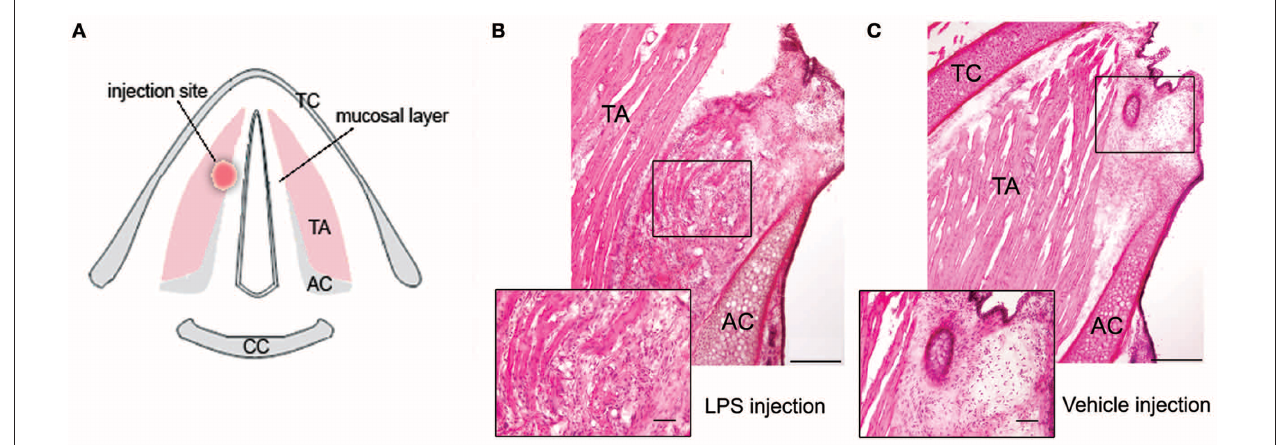
FIGURE 1 | (A) Schematic drawing of the transverse section of the larynx in the rat, depicting the site of LPS or vehicle injection in the right vocal fold. (B) Photomicrograph of the right vocal fold depicts changes observed following 72h after LPS injection; the magnified inset shows chronic inflammation and tissue re-organization at the site of LPS injection, characterized by the accumulation of macrophages and lymphocytes in the vocal fold mucosa, disintegrated muscle fibers, and increased